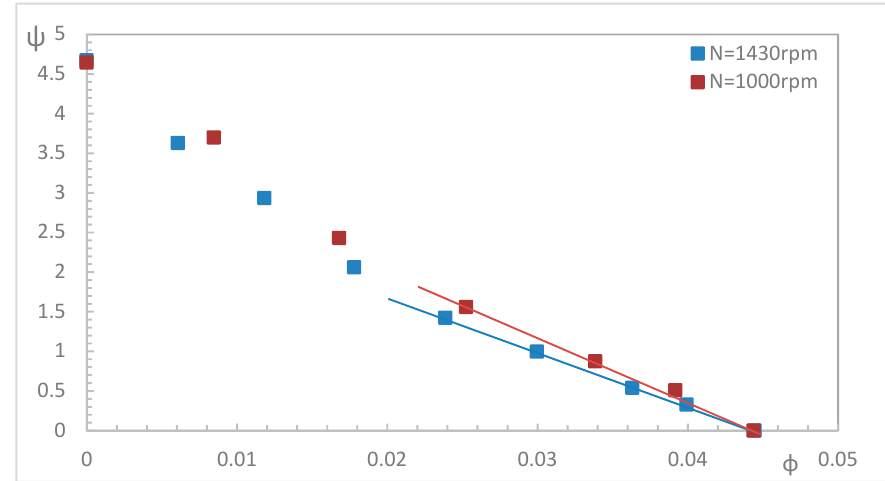
Figure 7. Experimental head versus flow coefficients for two rotational speeds. The two straight lines correspond to laminar leak regime zone.